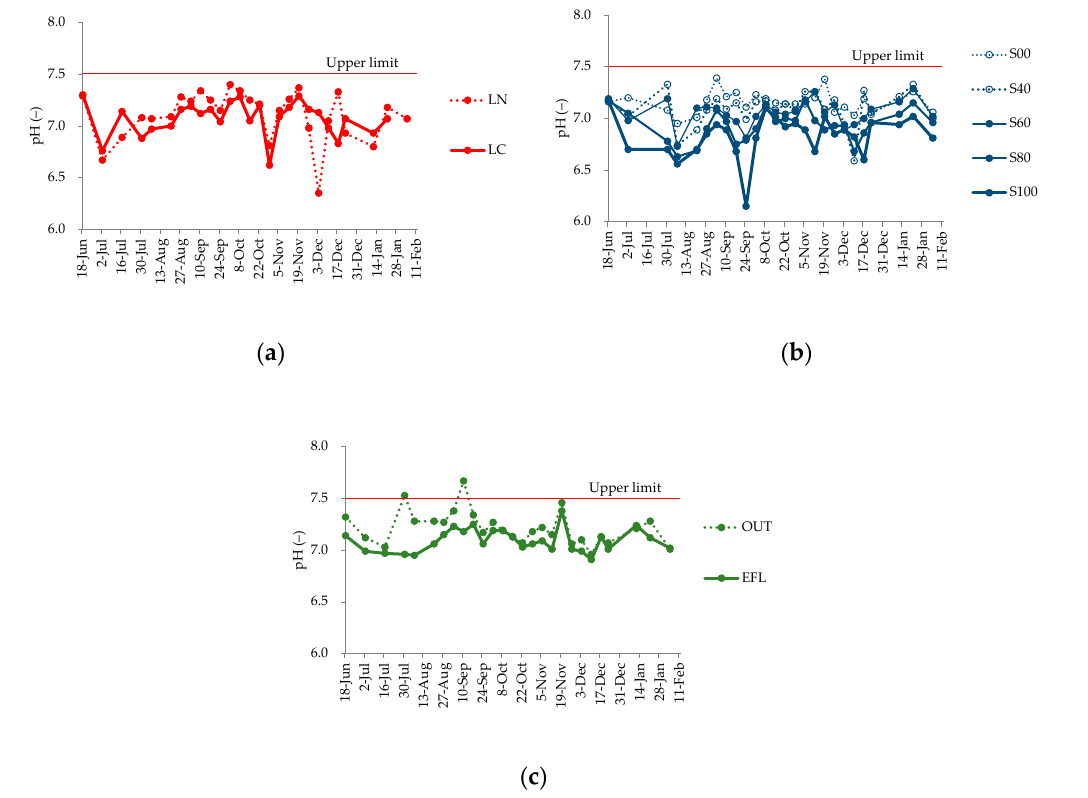
Figure 7. Changes in pH: ( a ) large section; ( b ) small section; ( c ) entire section. The ECs were approximately 150 µ S/cm until the beginning of July, exceeded 1100 µ S/cm in the end of August and then decreased to and stabilized at approximately 500 µ S/cm after the middle of September. No difference was noted between sections. The ORPs showed no clear trends, their values ranging from 100 to 400 mV (indicated values). The figures are